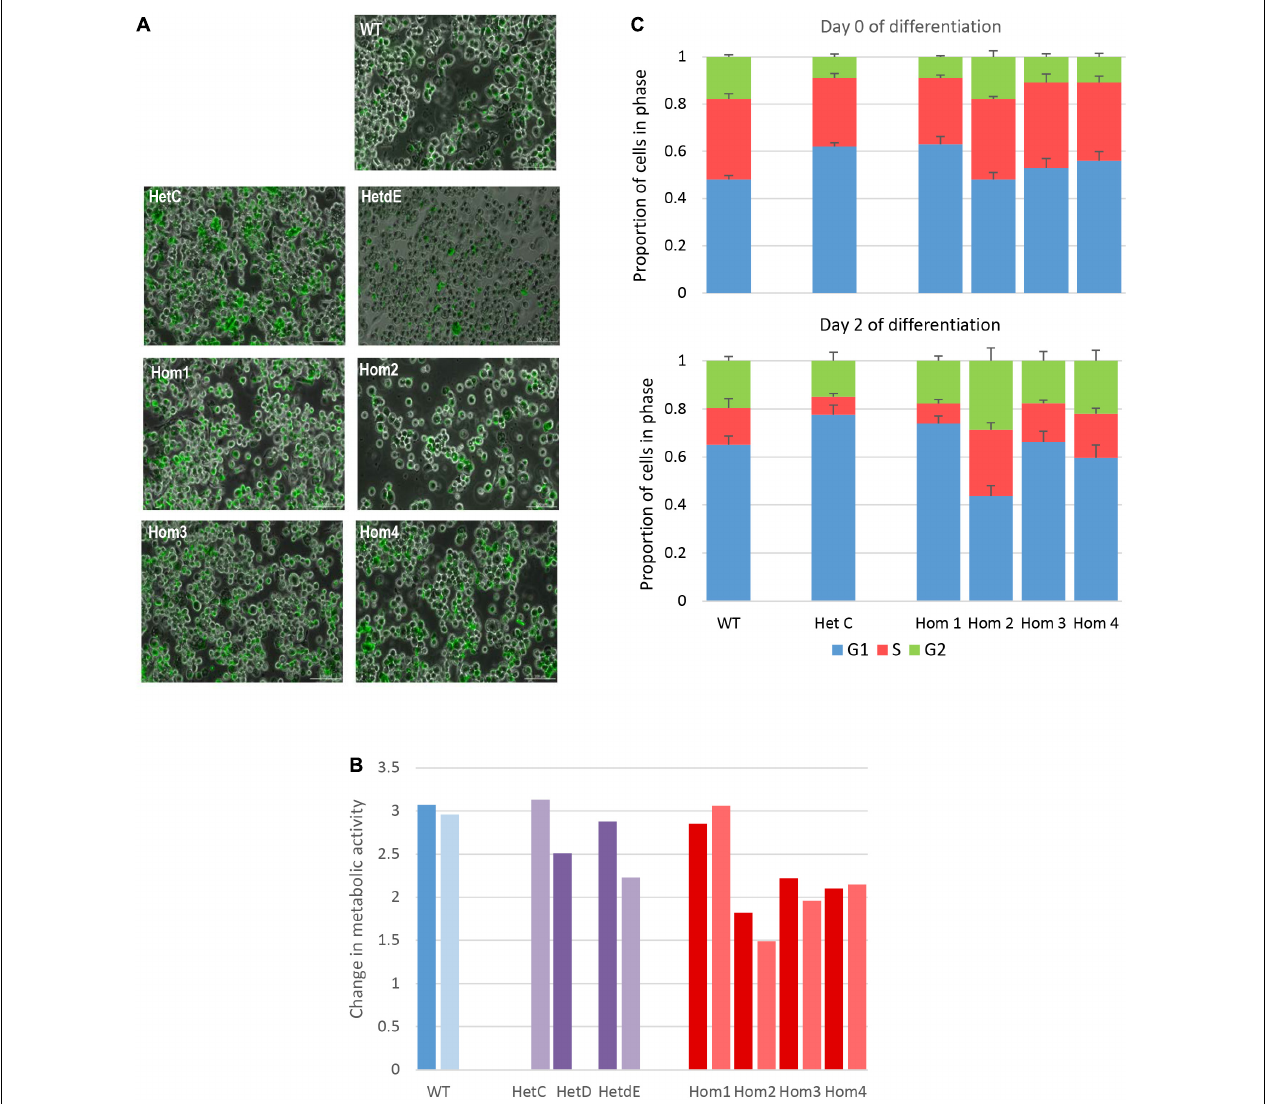
FIGURE 3 | Impact of USP16 knockout on cellular functions. (A) Phagocytosis of Zymosan particles by wild type and edited clones. Adherent THP-1 cells differentiated with PMA were incubated with FITC-labeled Zymosan particles for 1 h at 37 ◦ C and washed as described in Methods. Images show that the large majority of cells in each culture contained labeled (green) particles. (B) Proliferation of individual THP-1 clones measured using the MTT reduction assay. Cells were plated at 2 × 10 5 /ml and incubated for 48 h, prior to assay of viable cells as described in Methods section. Dark colors show an assay after initial expansion; light colors show a repeat assay of the same clones, after several passages. Y -axis shows the optical density after 48 h. Red – homozygotes; purple – heterozygotes; blue – wild type. HetD was only tested after the initial expansion and HetC was only tested after several passages. (C) Proportion of cells in different stages of the cell cycle in wild type and edited clones. Cell cycle was analyzed by flow cytometry of propidium iodide-stained cells as described in Methods. Results are the average of 3 (HetC) or 4 experiments. Upper panel – before differentiation; lower panel – after 2 days with PMA. Blue – G1 phase; orange – S phase; green – G2 phase. Error bars show standard